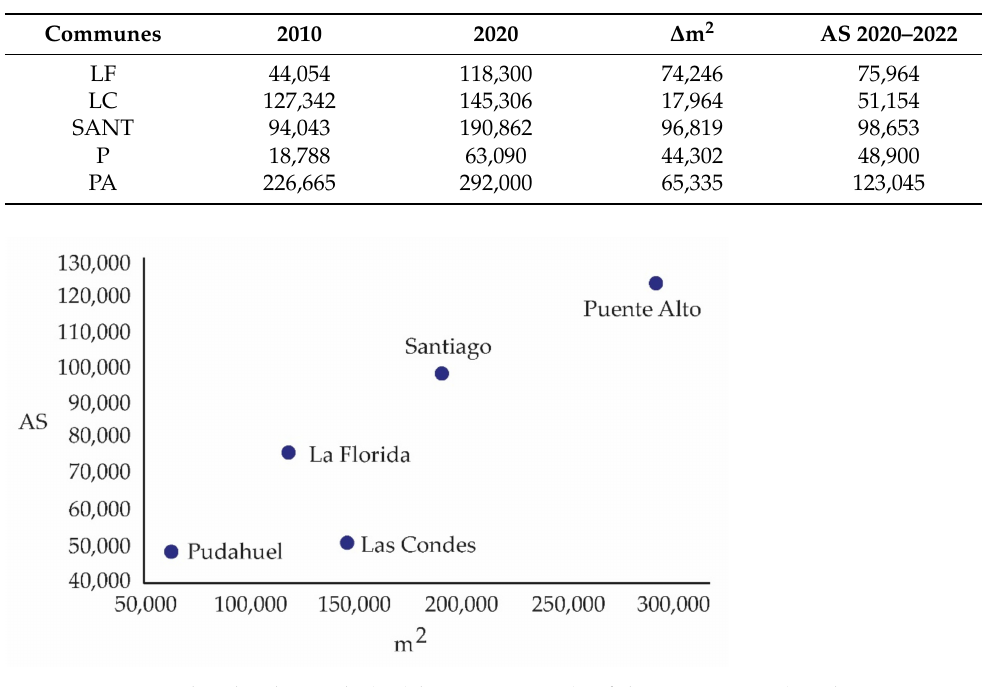
Figure 8. Accumulated sick people (AS) by communes (5 of the 7 communes) and square meters built, in